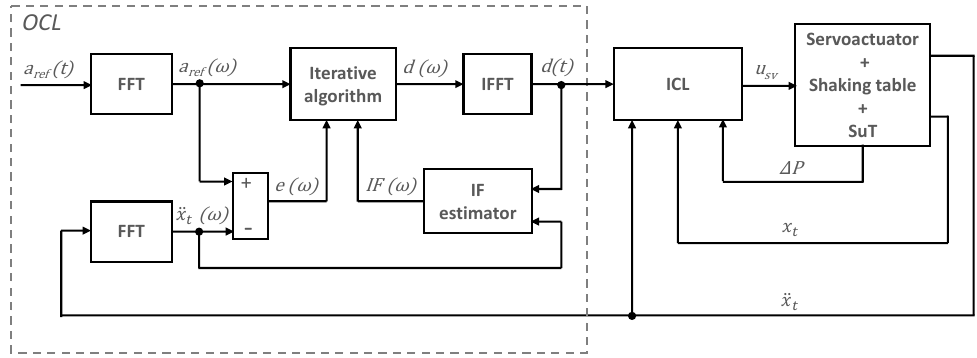
Figure 2. Generic frequency domain control architecture for shake table.